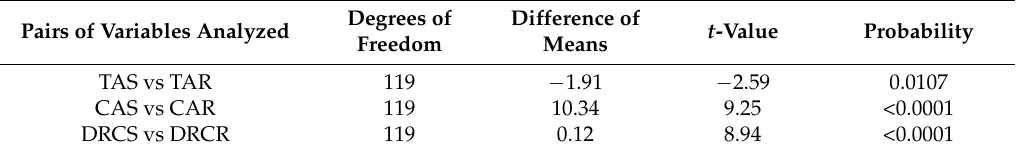
Table 5. Student’s t -test of paired anatomical variables in the study of side veneer grafts of Pinus engelmannii Carr. Pairs of Variables